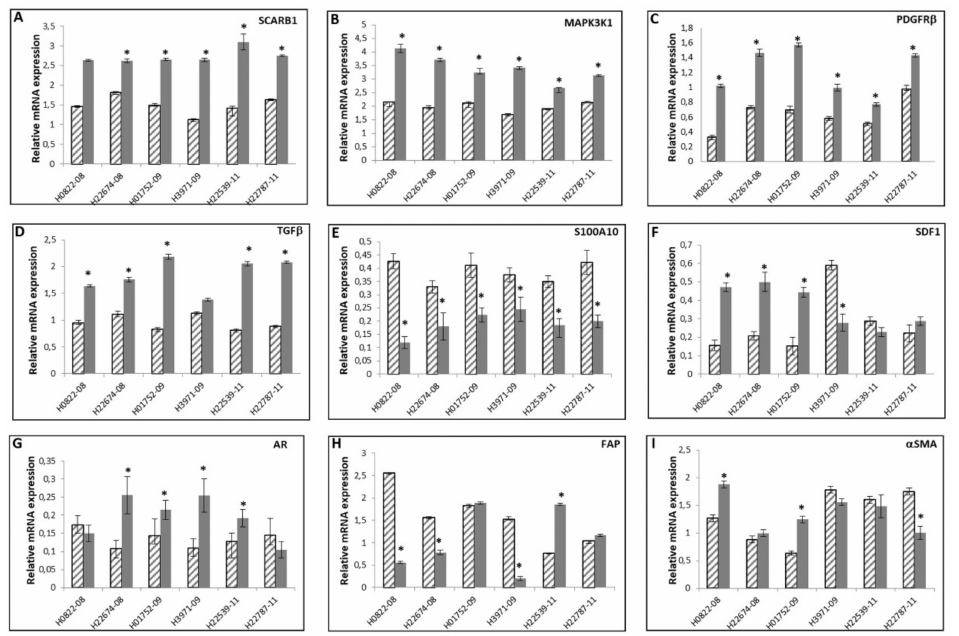
Figure 5. Expression of CAF-related genes in matched paired cancer and non-cancer associated fibroblasts. Expression levels of SCARB1 ( A ), MAPK3K1 ( B ), S100A10 ( C ), PDGFRb ( D ), TGFb ( E ), SDF1 ( F ), AR ( G ), FAP ( H ), α SMA ( I ) in PNAF (striped bars) and PCAF (gray bars) derived from six different prostate cancer patients (matched samples) were evaluated by RT-PCR. The values shown are the 2 − ∆∆ Ct ratios of the difference between cycle thresholds ( ∆ Ct) of the corresponding marker genes and the housekeeping gene TBP; n = 3 independent differentiation experiments * p ≤